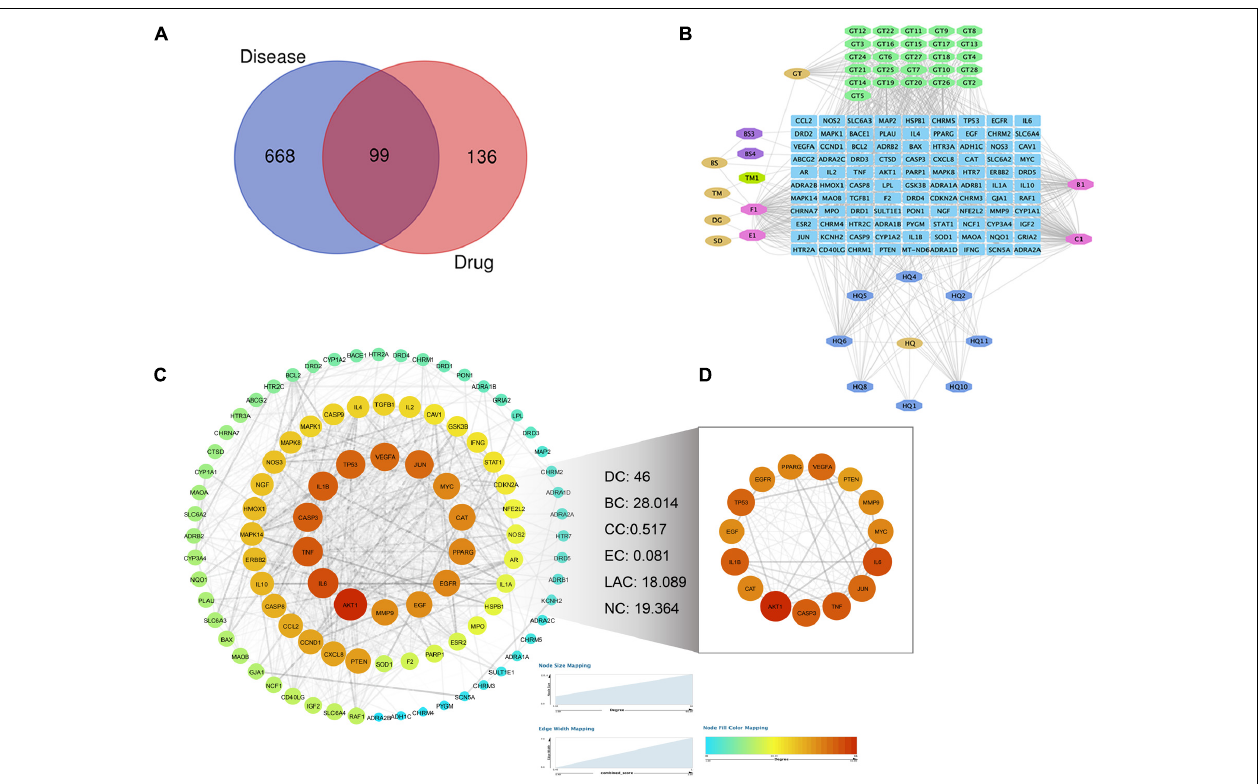
FIGURE 2 | Screening of targets for Parkinson’s disease treated by TPG. (A) Venn diagram of drug targets and disease targets. (B) The compound-target network for TPG on Parkinson’s disease. Blue indicates drug-disease intersection targets, other colors indicate active compounds of TPG, and pink indicates overlapped active compounds of TPG. (C) PPI network of Parkinson’s disease-related targets in TPG. (D) Core PPI network of Parkinson’s disease-related targets in TPG extracted from panel (C) . The size and color of nodes represent their degree values, which change from blue to orange representing values from low to high. The width of edges represents combined scores between the nodes. DC, degree centrality; BC, betweenness centrality; CC, closeness centrality; EC, eigenvector centrality; LAC, local average connectivity-based method; NC, network